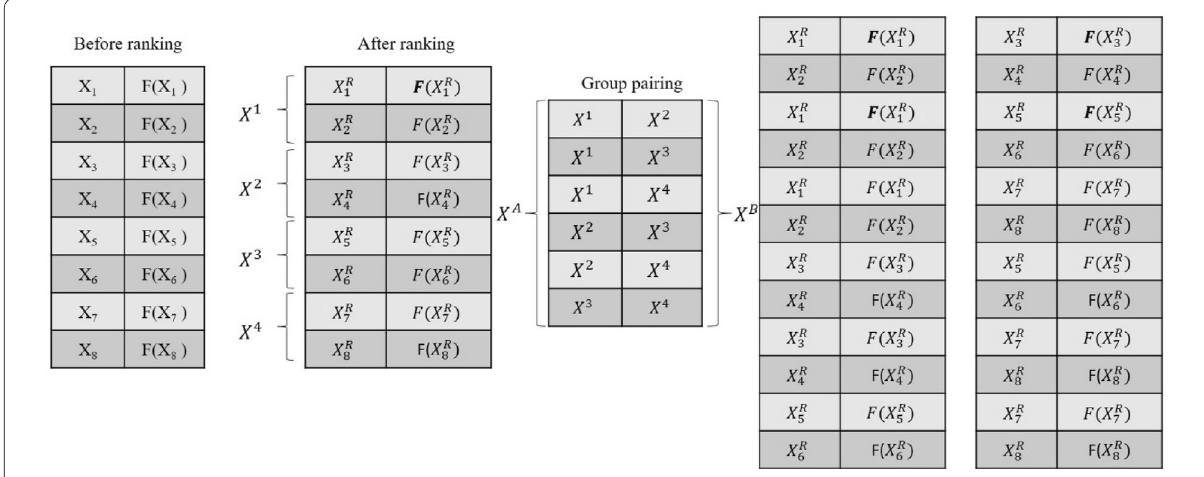
Fig. 4 An example of the RGS